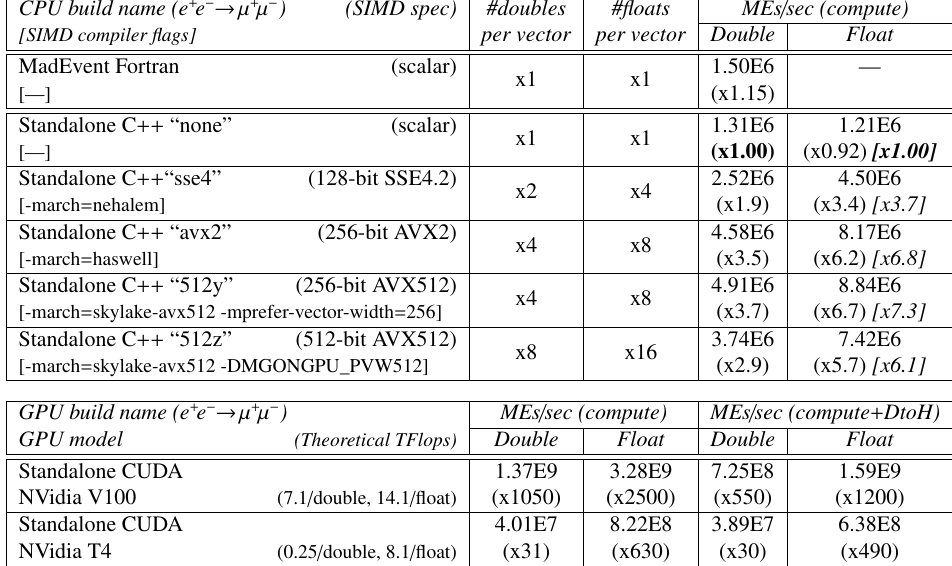
Table 2. Preliminary results. Throughput of the ME calculation for e + e − CUDA, using double or single precision floating point arithmetics. For Fortran: estimate from MA- TRIX1 in MadEvent. For C ++ and CUDA: measurements from the standalone executables, over 12 iterations with 524k events (2048 blocks, 256 threads per block in CUDA). Compilers: gcc9.2